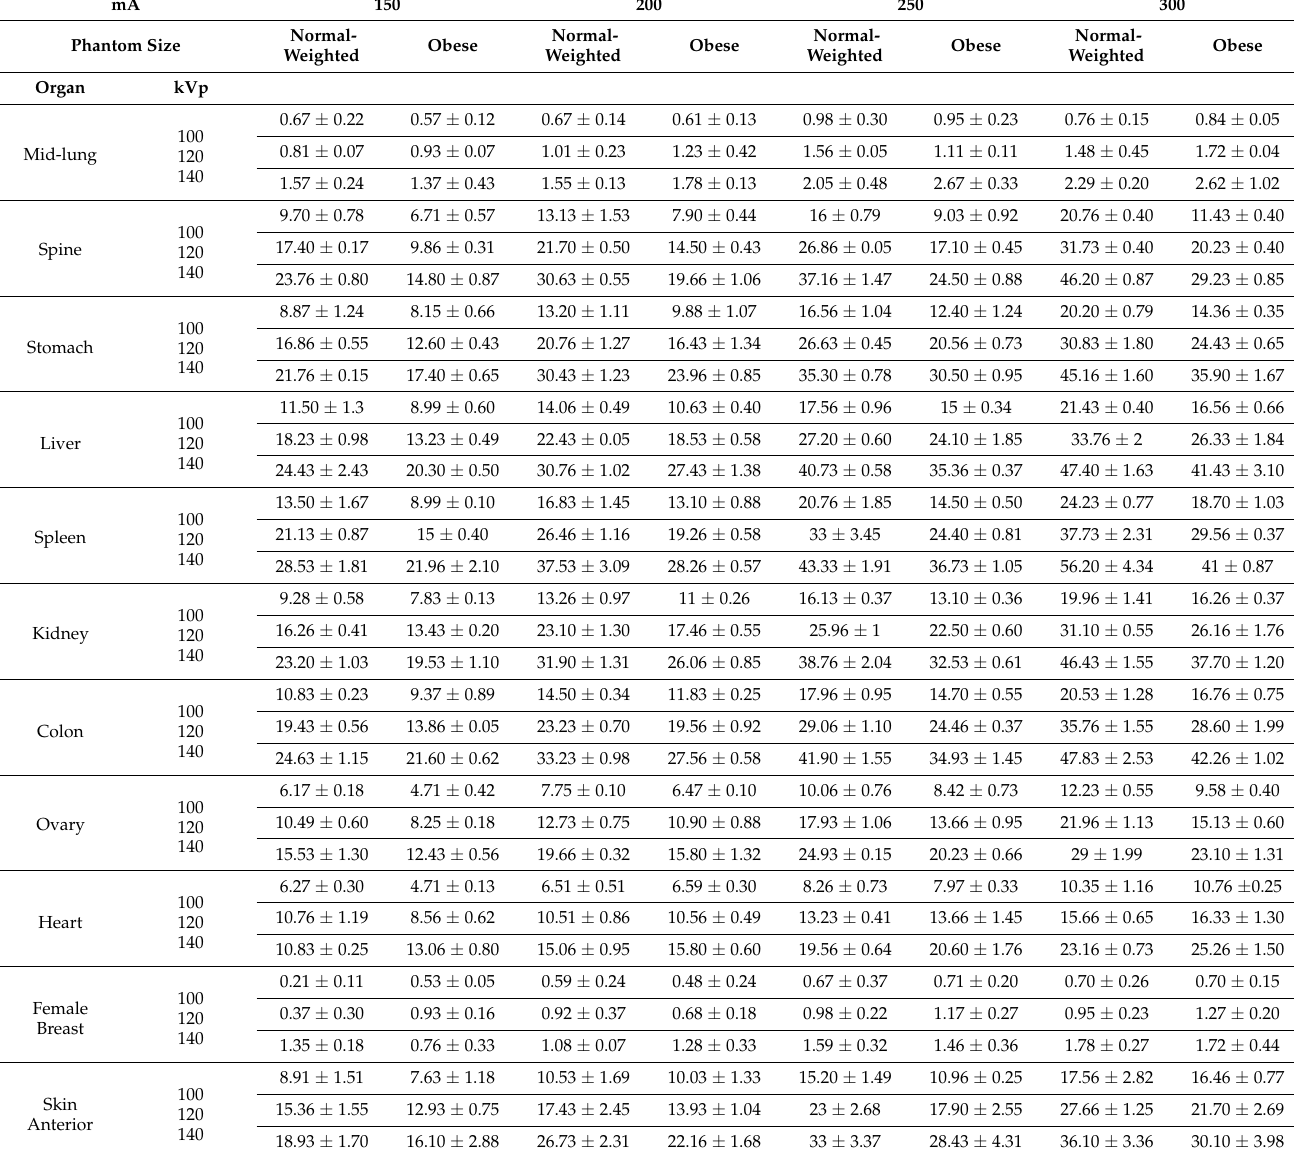
Table 3. Mean organ doses expressed in milliGray(mGy) ± standard